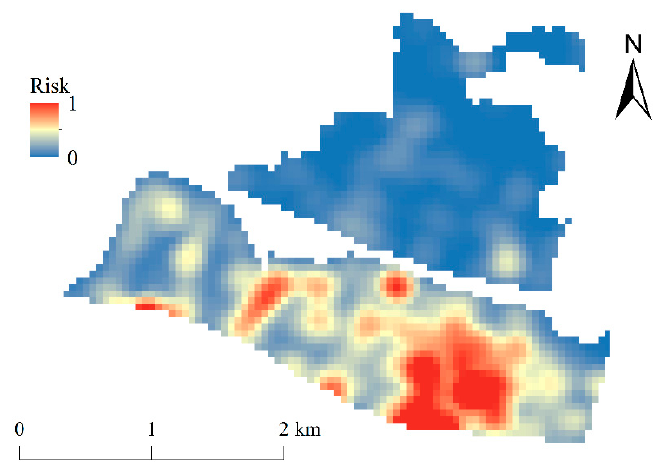
Figure 2. The spatial distribution of the historical crime risk in the XT police district (2 January 2017 to 3 December 2017).